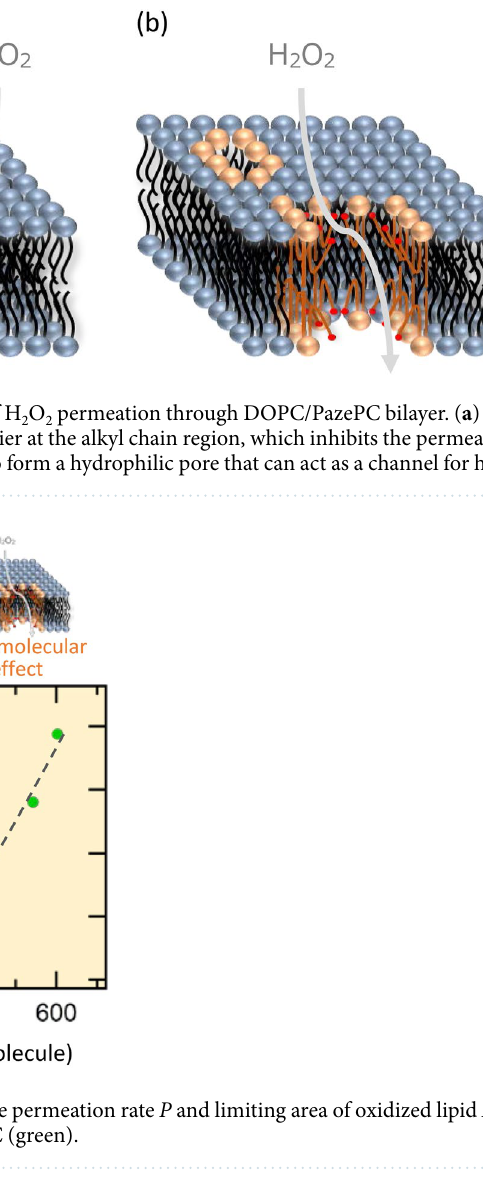
simulations 29,30,34 . Our assumption that PazePC underwent inter-molecular change to form pores can be sup- ported by the fact that PazePC demonstrated a significantly higher role as a permeation promoter, because the pores form a water channel that allow molecules to diffuse between the outside and inside of the liposome with- out any energy barrier. This process has kinetic superiority compared with permeation through a lipid mem- brane, which is the cause of high permeability in the presence of PazePC. Thus, in contrast to POVPC, that shows promoting activity by intra-molecular change, the origin of the enhanced permeability of PazePC would be attributed to the inter-molecular configurational change. From this finding, it was suggested that the origin of inhibition or promotion for the molecular permeation of lipid membrane should be discussed considering two independent molecular processes; intra- and inter-molecular processes. Correlation between the permeation rate and membrane structure at molecular scale further clarified the permeation mechanisms that are associated with the intra- and inter-molecular processes (Fig. 7). Permeation minimum appears at A ox-lipid = 200 Å 2 , whose P was almost the same as P of DOPC membrane without oxidized lipids. Under this condition, the oxidized lipids act as the permeation inhibitor by placing the hydrophilic oxi- dized group near the region of lipid head groups at the water/membrane interface. On the other hand, when the oxidized group could not adopt the looped structure and A ox-lipid became smaller, the role as permeation inhibitor became weakened. Instead, incorporating the oxidized group inside the alkyl chain weakened the hydrophobic barrier, which increased the partition coefficient of H 2 O 2 into the bilayer. Enhanced H 2 O 2 partition resulted in the increase in P at smaller A ox-lipid side. Switching between looped and nonlooped structure is an intra-molecular process, which can be controlled through hydrophilicity and alkyl chain length of the oxidized group. Higher numbers of hydrophilic oxidized groups with longer alkyl chain tends to form the looped structure that makes